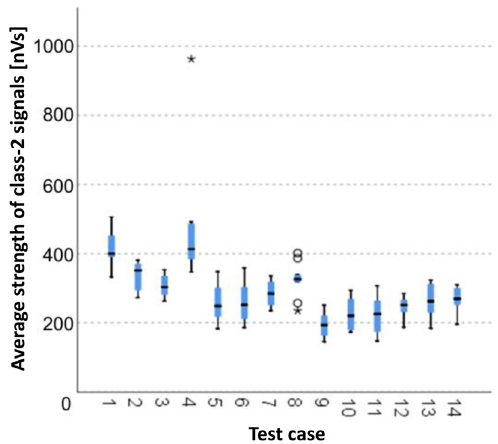
Figure 6. Graphic presentation of the Kruskal–Wallis test results for independent samples: average strength of class-2 signals.